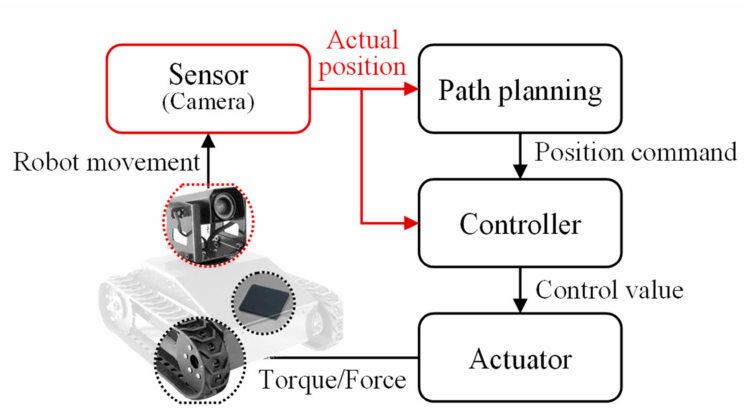
Figure 1. Driving mechanism of the mobile